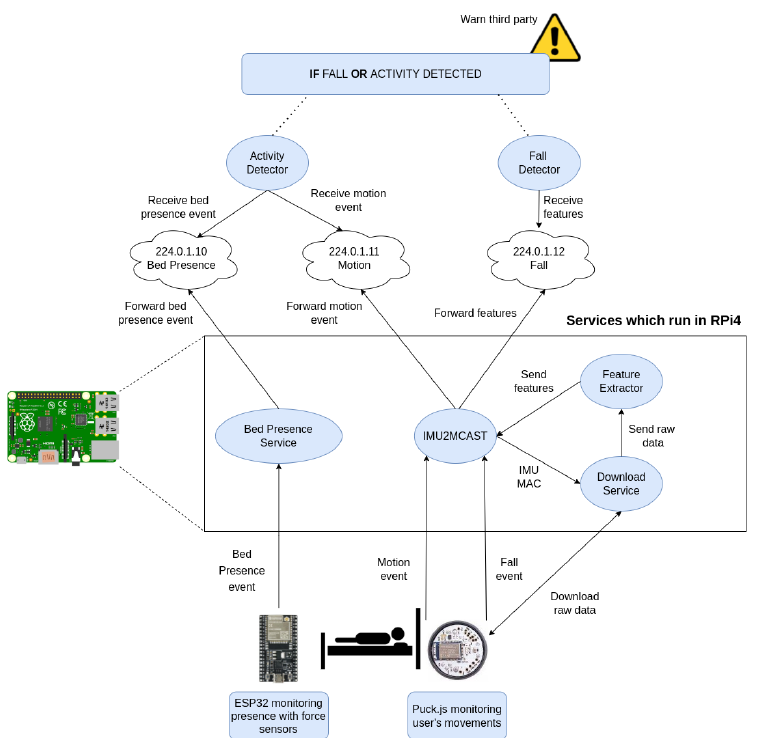
Figure 6. Diagram showing how the system works in a general